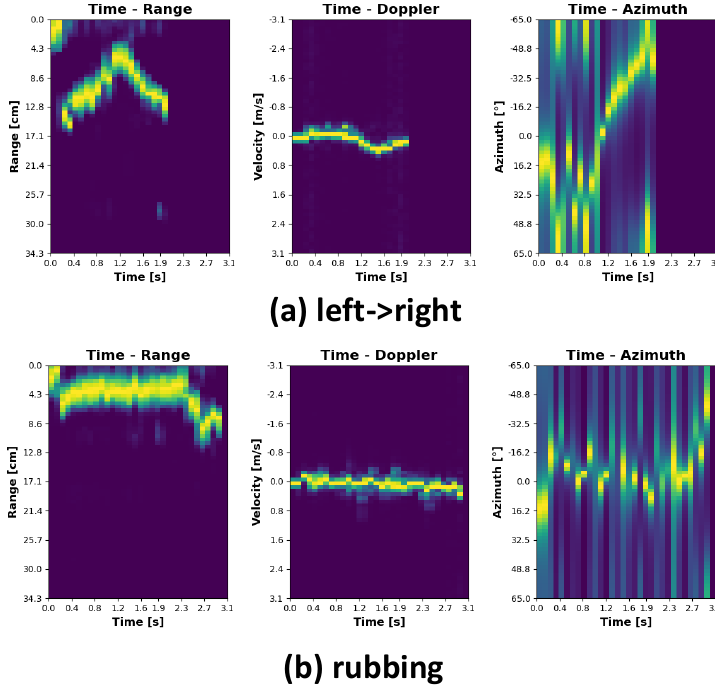
Figure 9. Gesture signatures cont.